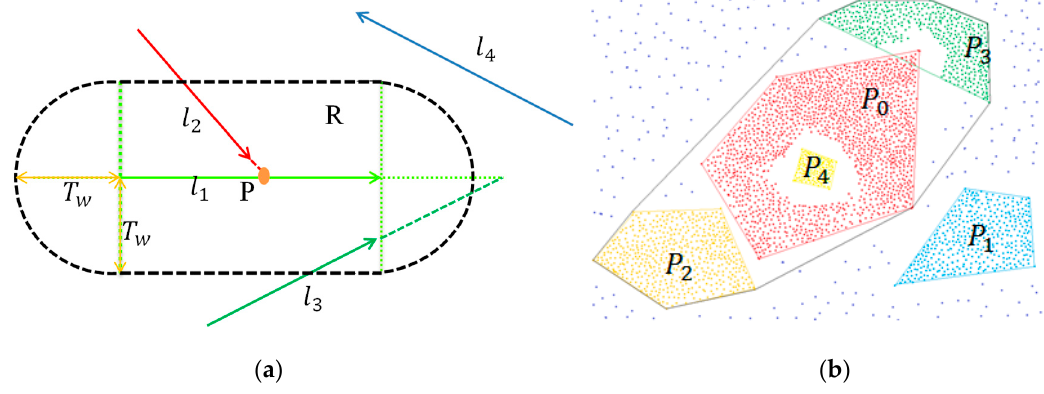
Figure 5. Intersection point computation ( a ) and merging of convex hulls ( b